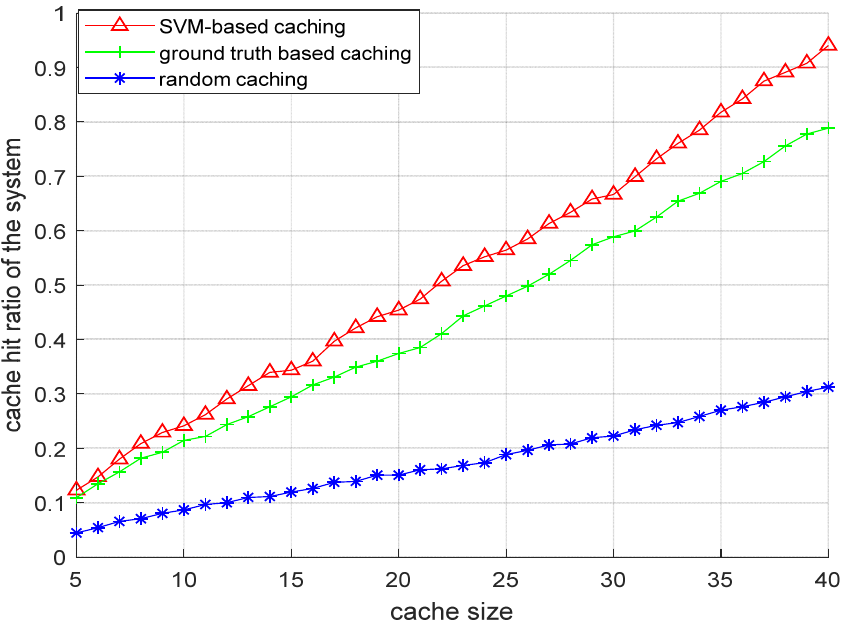
Figure 6. Performance comparison of different content caching techniques for D2D assisted multi- tier cellular networks.